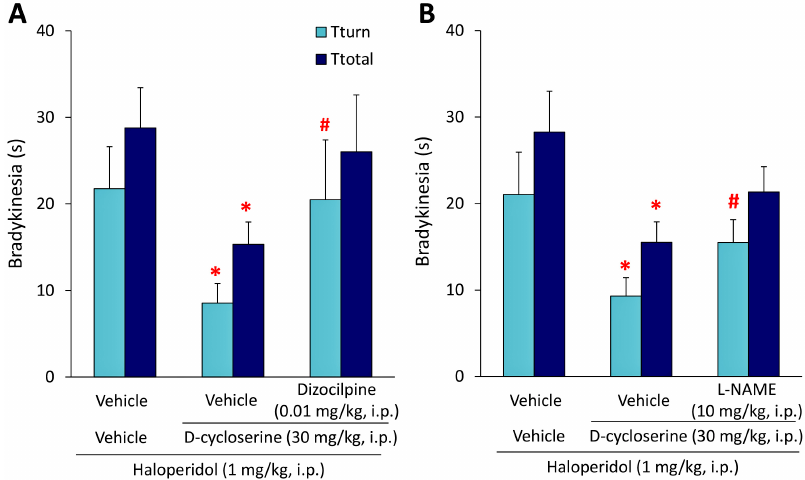
Figure 2. Effects of dizocilpine or L-N G -Nitro- L -arginine methyl ester (L-NAME) on the ameliorative action of D -cycloserine (DCS) against haloperidol (HAL)-induced bradykinesia. ( A , B ) Mice received dizocilpine (0.01 mg/kg, i.p.), L-NAME (10 mg/kg, i.p.), or vehicle simultaneously with DCS (30 mg/kg, i.p.) or vehicle 15 min before the HAL injection (1 mg/kg, i.p.). The pole test was performed 30 min after the HAL injection. Each column represents the mean ± S.E.M. of 12–23 mice. These data were analyzed using the Mann-Whitney U -test. * p < 0.05: Significantly different from the value with HAL alone. # p < 0.05, significantly different from the value with HAL + DCS.